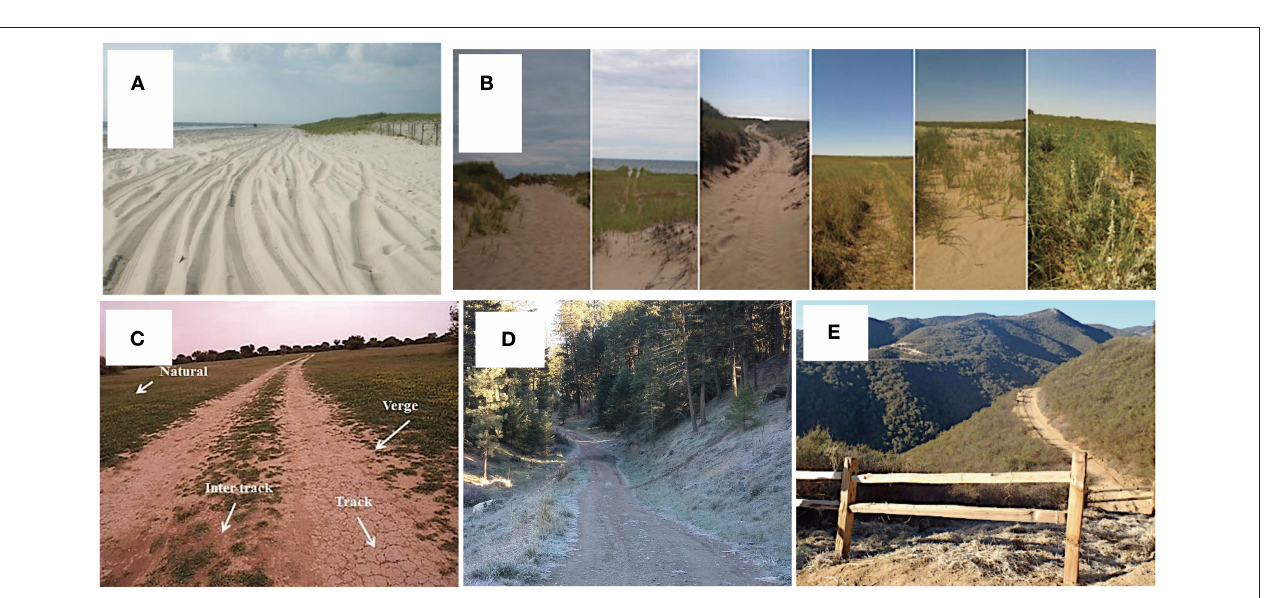
FIGURE 2 | Examples different habitats and locations impacted by off-road vehicle (ORV) traffic. (A) ORV vehicle tracks on a beach in New Jersey, USA (Kelly, 2014); (B) Scale of impacted dunes from high- to low impact (left to right) in New Brunswick, Canada (Hogan and Brown, 2021); (C) Pictorial demonstration of different microhabitats created by ORV tracks in Saudi Arabia (Assaeed et al., 2019); (D) ORV trail in Douglas-fir forest in the interior of British Columbia, Canada (Photo by: Laura Ploughe) (E) ORV trail in a chapparal in California, USA (Cole et al.,